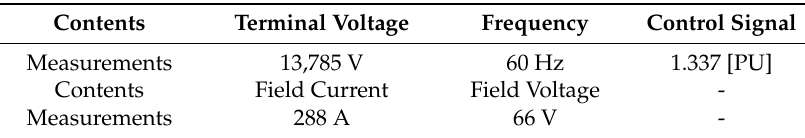
Figure 16. The initial waveform of terminal voltage in auto mode (No-load state). Table 2. The specification of a gas turbine at the thermal power plant (1).